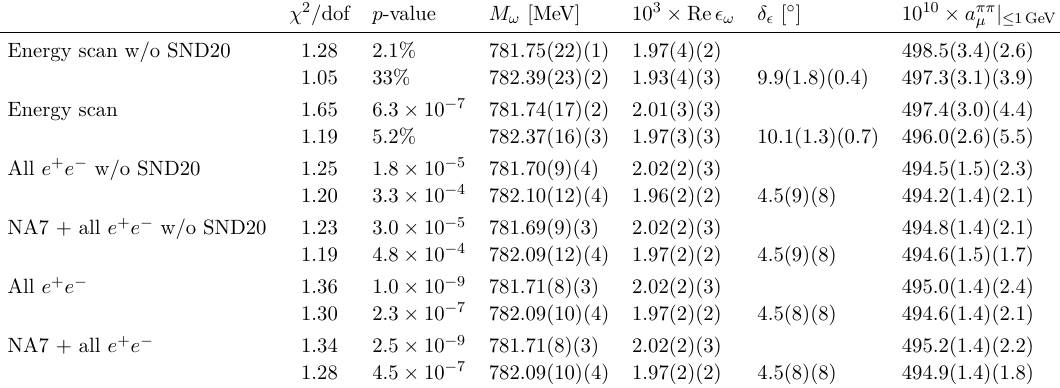
Table 2 . Comparison of fits to combinations of experiments with and without a phase δ (cid:15) in (cid:15) ω . The first error is the fit uncertainty, inflated by systematic